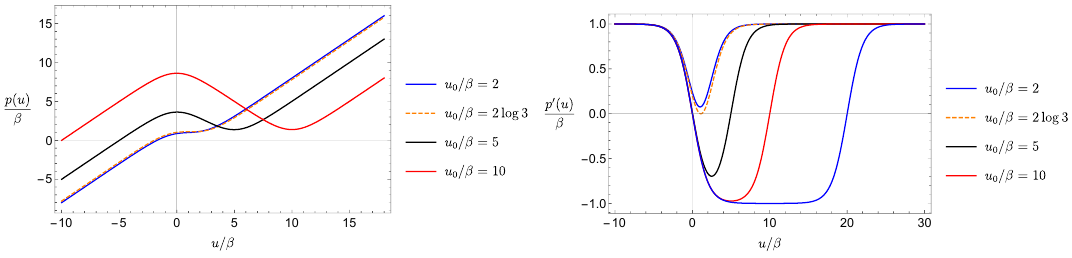
Figure 23 . Left: transformation function p ( u ) with various u 0 . Right: first order derivative of the transformation function p 0 ( u ) with various u